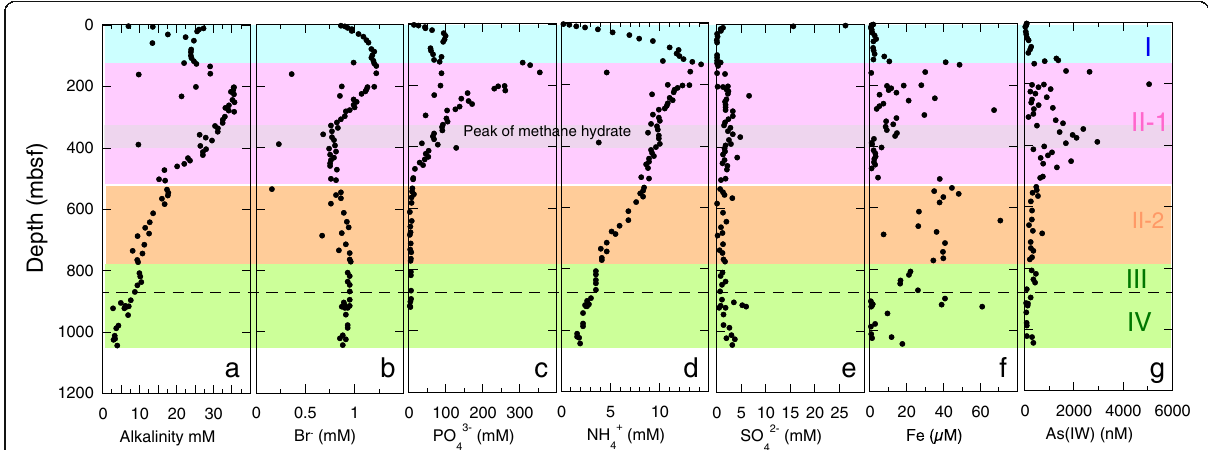
Fig. 6 Relationships of interstitial water chemistry to the subsurface depth of sediment column at C0002. Data from a to f are from Strasser et al. (2014), and g from this